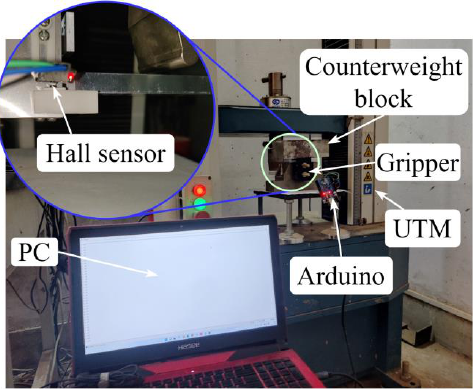
Figure 9. Clamping force detection system calibration testing field.